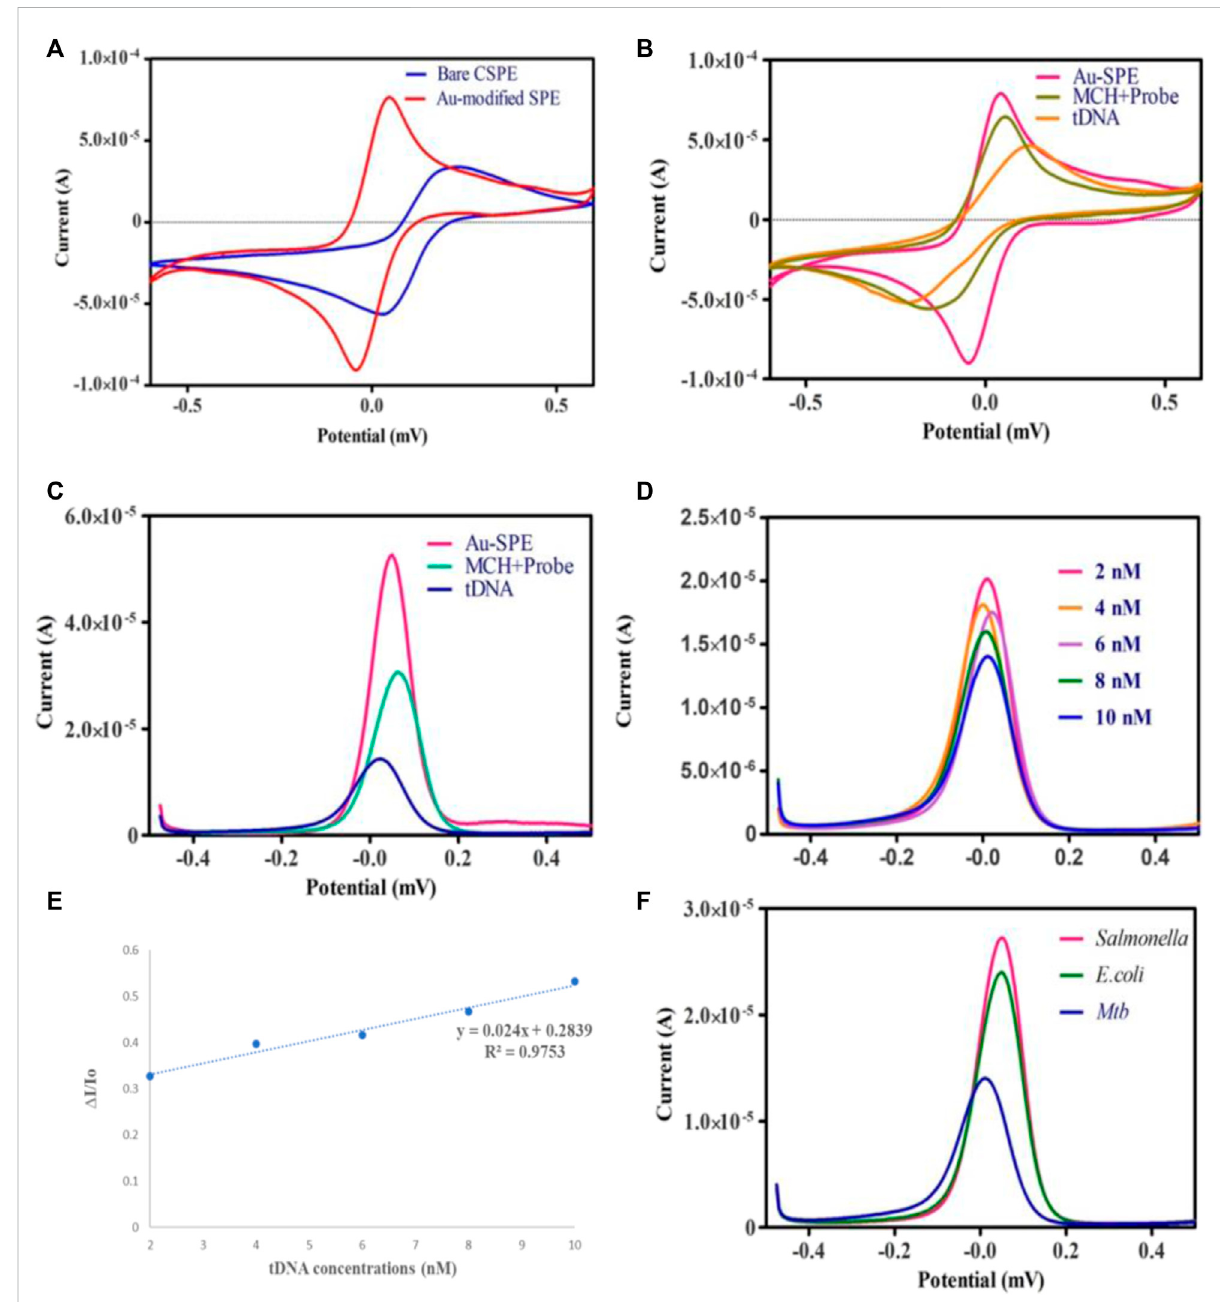
FIGURE 4 (A) Cyclic voltammetry of bare Carbon SPE and electrodeposited Au-SPE. (B,C) CV and DPV analysis of Au-modi fi ed SPE functionalized with ssDNA probe/MCH and tDNA in 5 mm K 3 [Fe (CN) 6 ] and 0.1 M KCl. (D) DPV analysis of different Mtb -tDNA concentrations ranging (2nm – 10 nm)